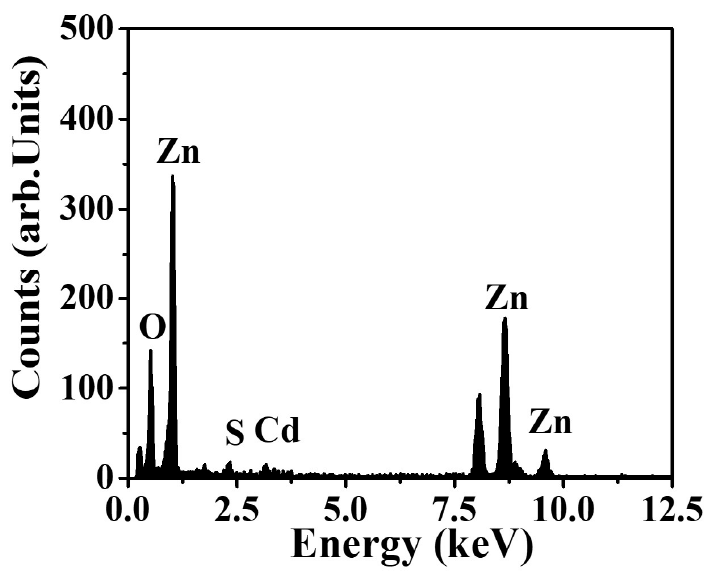
Figure 2. EDX spectrum of the prepared powder after calcination at 200 ◦ C for 1